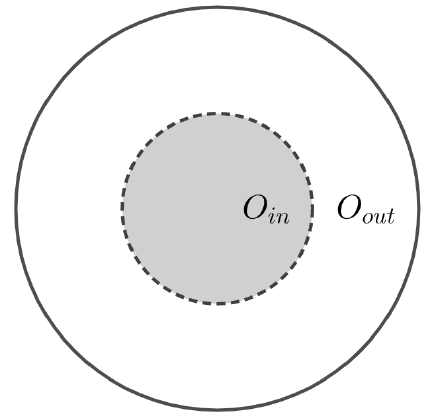
Figure 16 . Schematic diagram for AdS black hole, where the gray area denotes the black hole “interior”. Note that the dotted line is the RT surface derived from the generalized entropy, which is not necessarily the horizon. O in and O out corresponds to O I and O ¯ island,